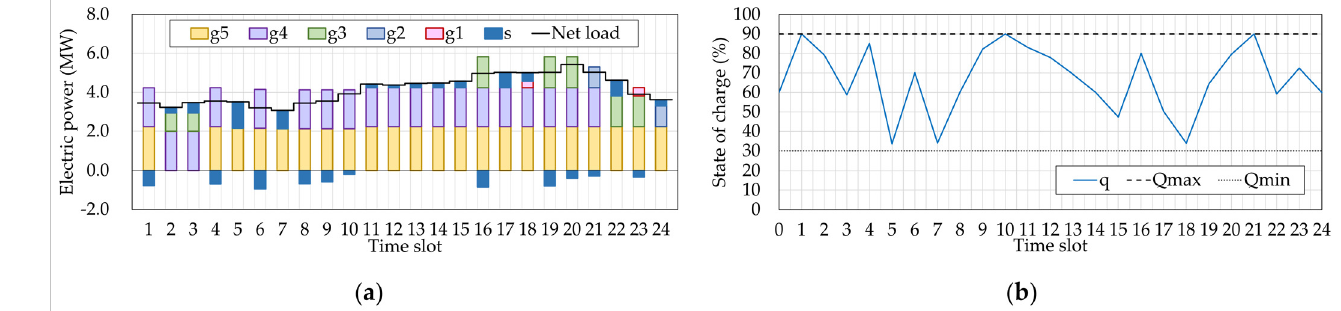
Figure 4. Obtained solution in Case 1 ( Q ∗ = 2.62 (MWh)): ( a ) operation schedule; ( b ) transition of SOC level.